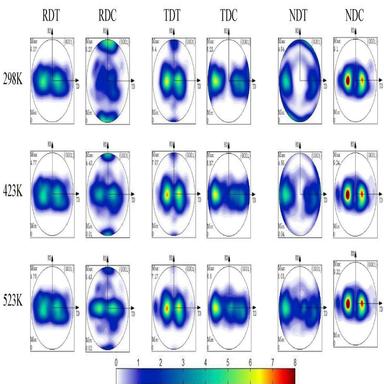
Predicted (0001) pole figures after 20% tension/compression along six directions for the α-Ti tube, indicating that the anisotropy and T-C asymmetry in terms of texture evolution decrease with temperature.